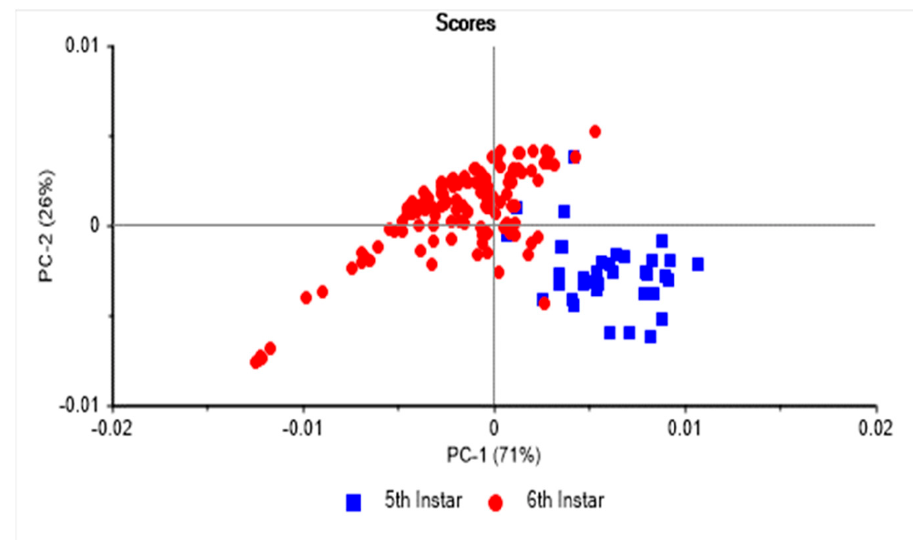
Figure 2. Principal component score plot of 5th instar larvae and 6th instar pre-pupae reared on soy waste and spent brewer’s grains analysed using near infrared spectroscopy.